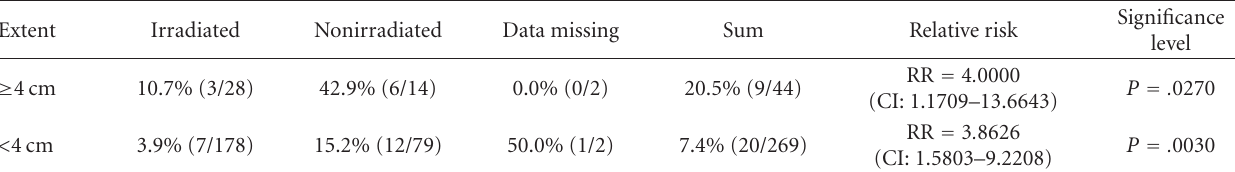
Table 4: Ipsilateral local recurrence rates by disease extent and postoperative irradiation in extensive tumors and tumors of limited extent treated with breast-conserving surgery, Falun 1996–1998, 10-year followup.